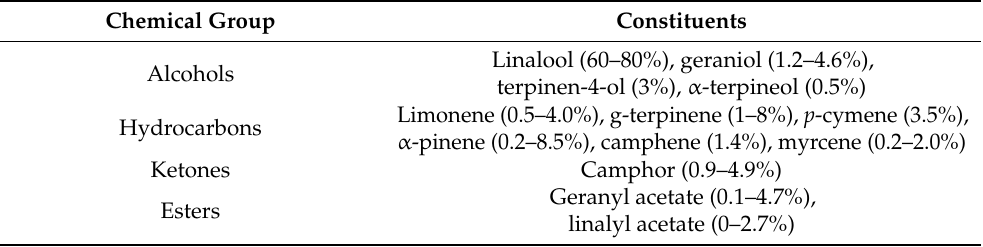
Table 1. The chemical composition of essential oil of coriander